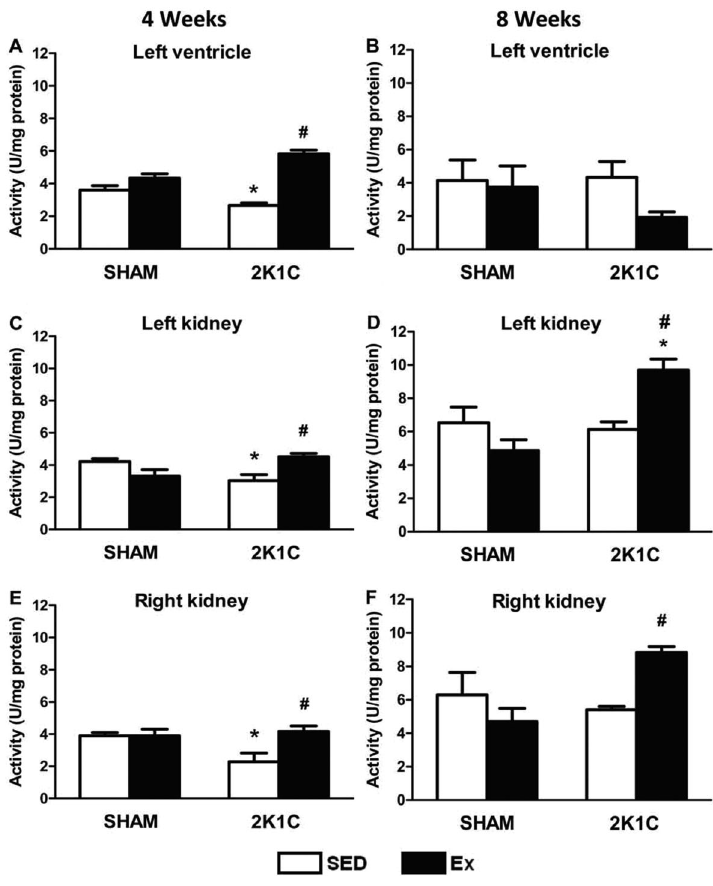
Figure 9. Catalase activity (U/mg protein) in the left ventricle ( A and B ), left kidney ( C and D ), and right kidney ( E and F ) of normotensive (SHAM, n=10) and hypertensive (2K1C, n=10) rats, either sedentary (SED) or subjected to 4 or 8 weeks of physical exercise training (Ex). *P o 0.05 com- pared to SHAM SED group. # P o 0.05 compared to 2K1C SED (ANOVA followed by Bonferroni